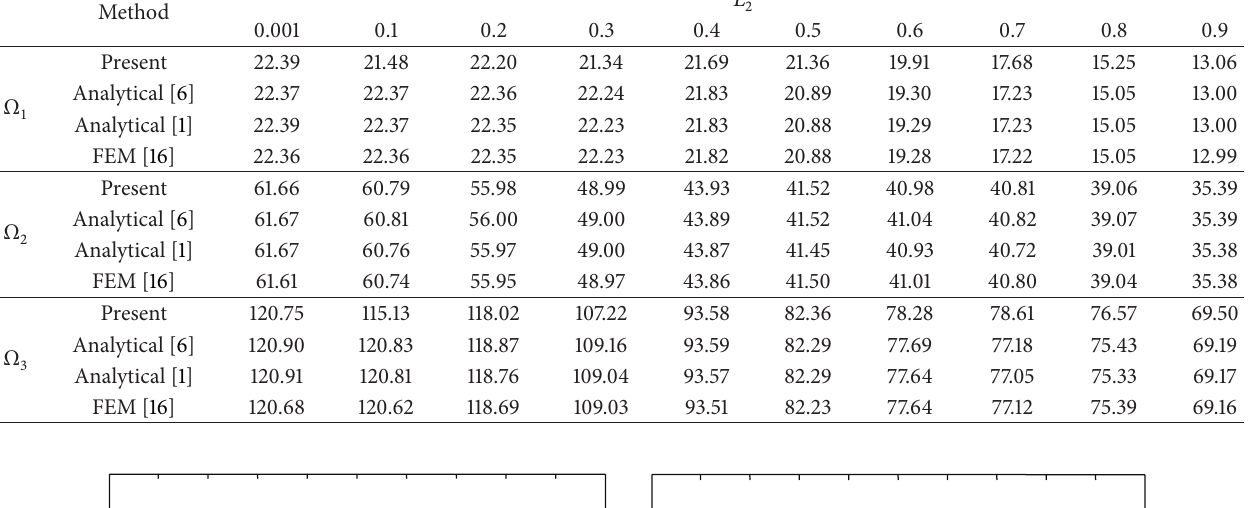
Table 2: First three dimensionless natural frequencies of the beam with a central and midplane delamination. Method